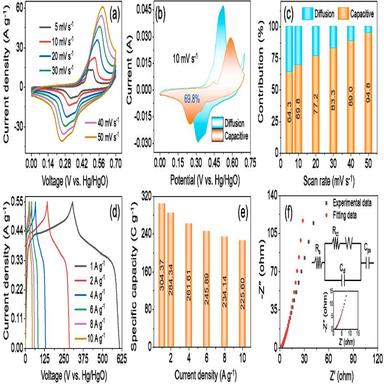
(a) The CV curves of MnCo2O4.5 nanosheets at different scan rates, (b) capacitive (orange) and diffusion-controlled (cyan) contributions to the total charge storage of MnCo2O4.5 NSs at 10 mV s − 1 , (c) normalized contribution ratio of capacitive (orange) and diffusion-controlled (cyan) capacities for MnCo2O4.5 nanosheets at different scan rates, (d) the GCD curves of MnCo2O4.5 nanosheets at current density of 1–10 A g− 1 , (e) the histogram of specific capacity vs. current density for MnCo2O4.5 nanosheets